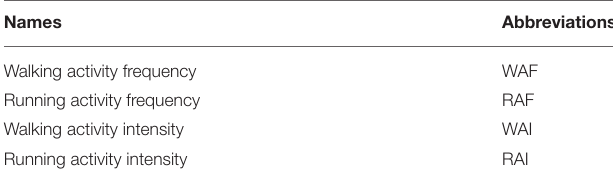
TABLE 1 | Names and abbreviations of independent